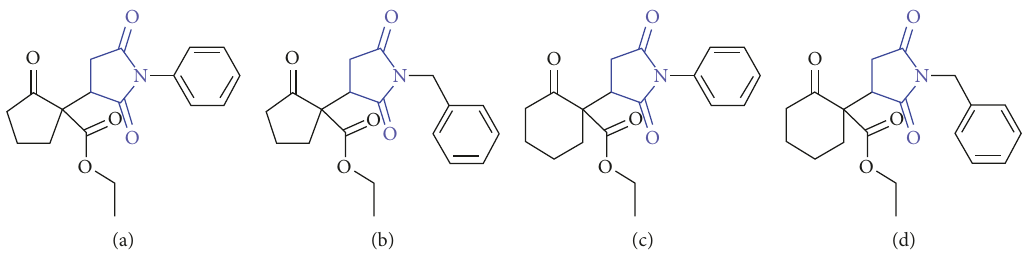
Figure 2: Structures of the synthesized succinimide